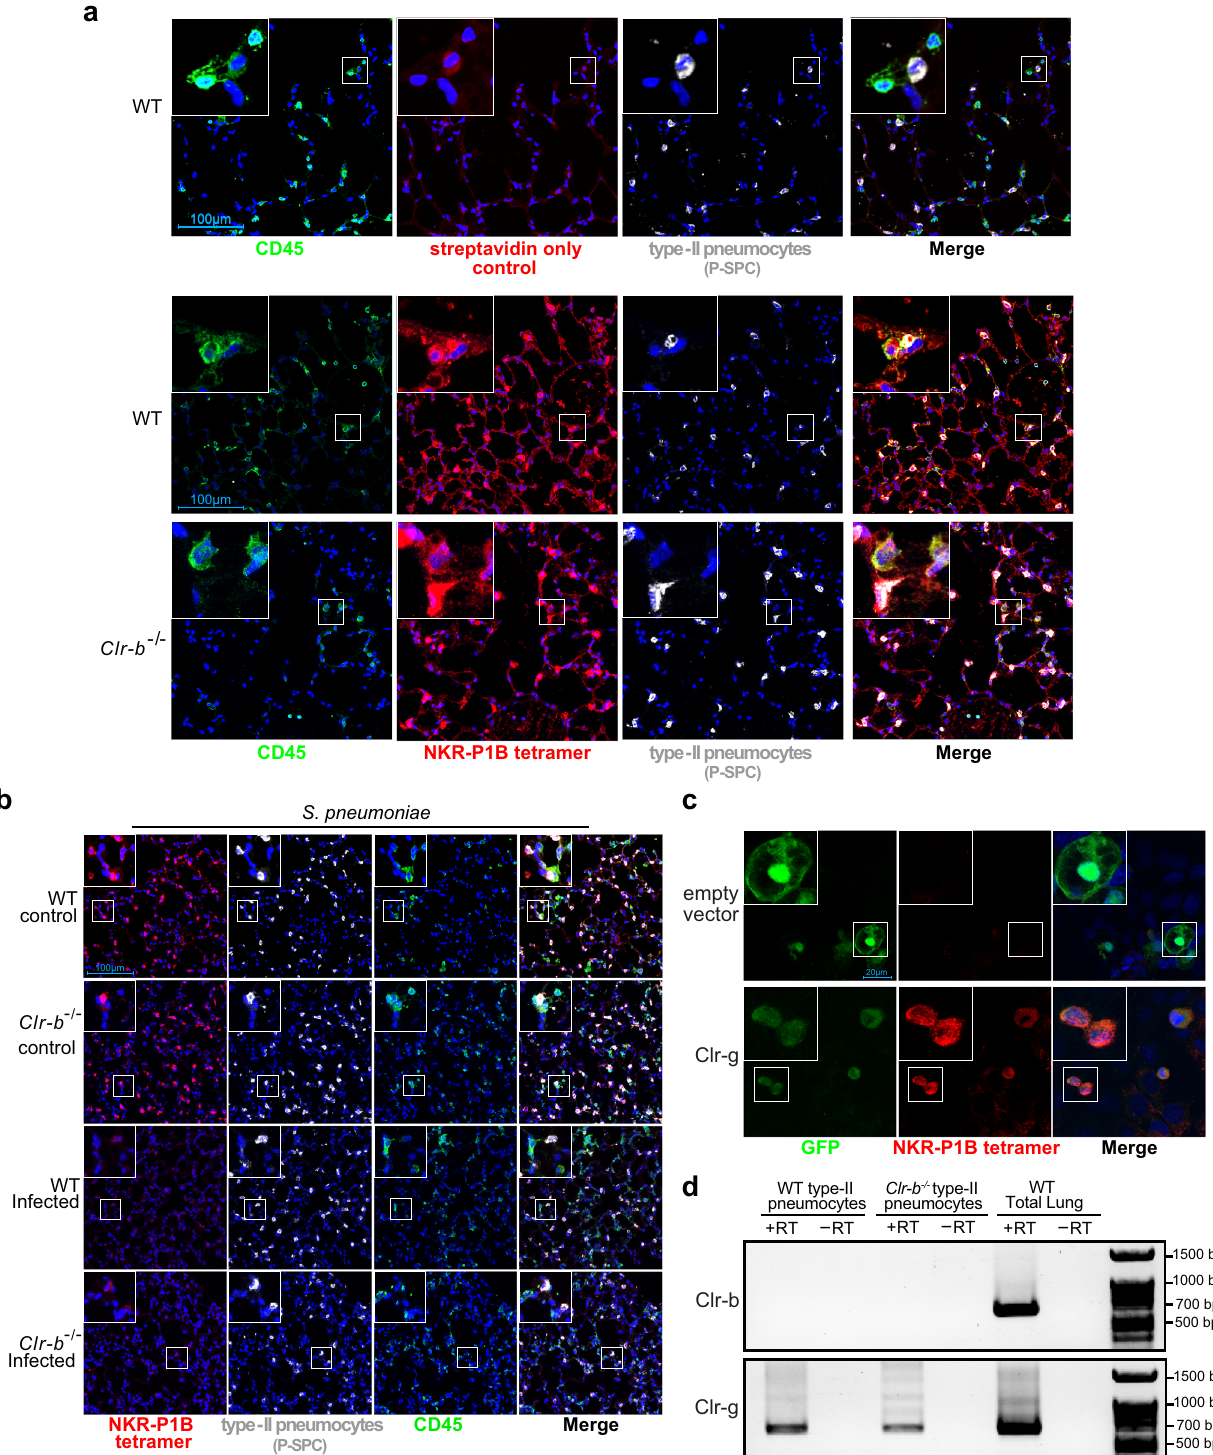
Fig. 7 | Infection downregulates NKR-P1B ligand expression. a Confocal image stacks of WT and Clr-b − / − frozen lung sections stained with CD45 (Green), NKR-P1B tetramer (Red), DAPI (Blue), and pro-surfactant protein C (White). b Confocal image stacks of WT and Clr-b − / − frozen lung sections post-infection with S. pneu- moniae harvested 3 days post-infection. Sections are stained with CD45 (Green), NKR-P1B tetramer (Red), DAPI (Blue), and pro-surfactant protein C (White). c MLE- 12cellstransiently transfected with either empty vectororClr-g expressing vector.